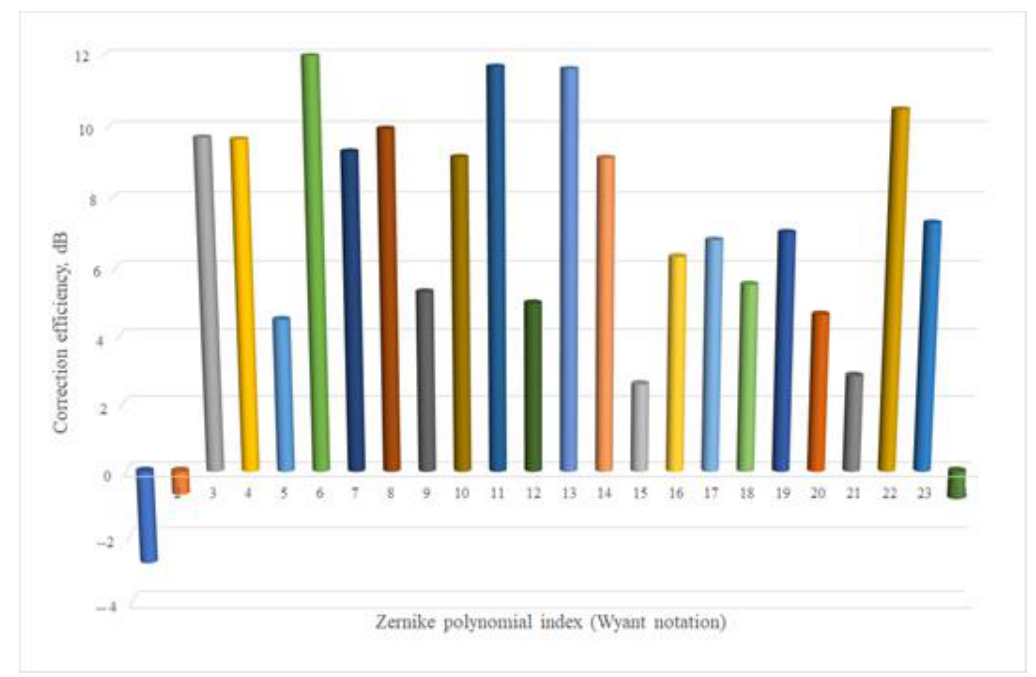
Figure 14. Correction efficiency for each Zernike mode.